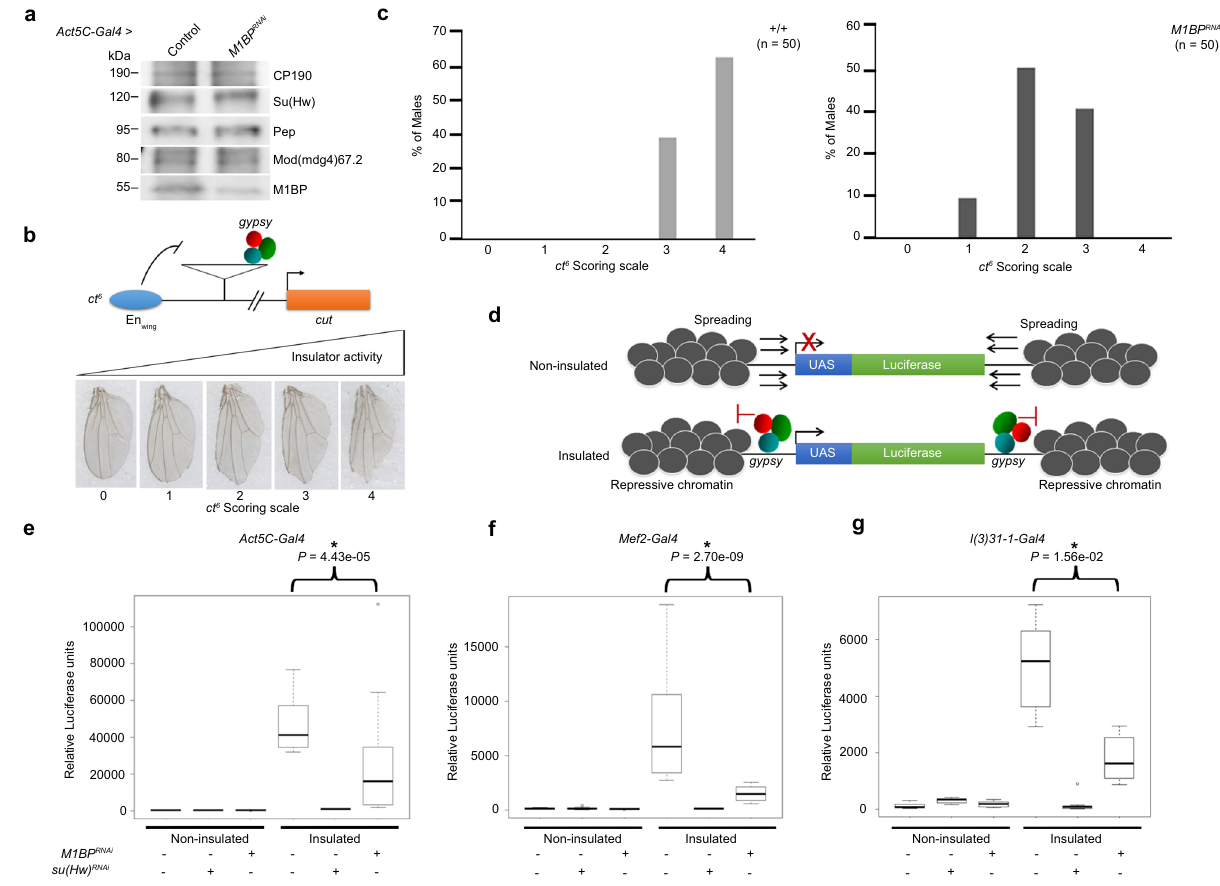
Fig. 2 M1BP promotes gypsy -dependent enhancer-blocking and barrier activities. a Western blotting of male third instar larval extracts for M1BP, insulator proteins, and Pep loading control in control and M1BP RNAi knockdown fl ies using Act5C-Gal4 driver. Samples from the same experiment were run on different lanes of the same gel for proteins with similar molecular weights. Western blotting experiments were performed using two independent biological replicates with similar results. b M1BP promotes enhancer-blocking activity at ct 6 . Top: schematic diagram of reporter system. The gypsy retrotransposon is inserted in between the promoter of cut and wing margin (En Wing ) enhancer. Bottom: insulator activity for ct 6 was scored in male fl ies on a scale of 0 – 4. 0, no notching; 1, slight notching in anterior tip of wing; 2, mild notching throughout posterior wing; 3, extensive notching both in anterior and posterior wing; 4, severe notching throughout the anterior and posterior wing. c Graph represents quanti fi cation of ct 6 wing phenotype of male wild- type ( + / + ) and M1BP RNAi using Ser-Gal4 driver. n , total number of fl ies scored. d Depletion of M1BP shows reduced gypsy -dependent barrier activity in all tissues tested. Schematic diagram of non-insulated UAS-luciferase system shows spreading of repressive chromatin can reduce luciferase expression, but presence of the gypsy insulator acts as a barrier and allows for luciferase activity. e Relative luciferase activity of insulated or non-insulated male larvae of control and M1BP RNAi driven by Act5C-Gal4 driver, f Mef2-Gal4 driver, and g l(3)31-1-Gal4 driver. Luciferase values of all genotypes are plotted as box and whisker plots using one-way ANOVA followed by Tukey HSD post hoc tests to calculate P values for pairwise comparisons. The box represents the 25 – 75th percentiles, and the median is indicated. The whiskers show the minimum and maximum values. For each genotype, n = 12 individual larvae. Bracket indicates P values of two-way comparisons (* P < 0.05) and all comparisons are shown in Supplementary Table Table 4). We conclude that M1BP promotes gypsy -dependent barrier activity in all tissues tested.